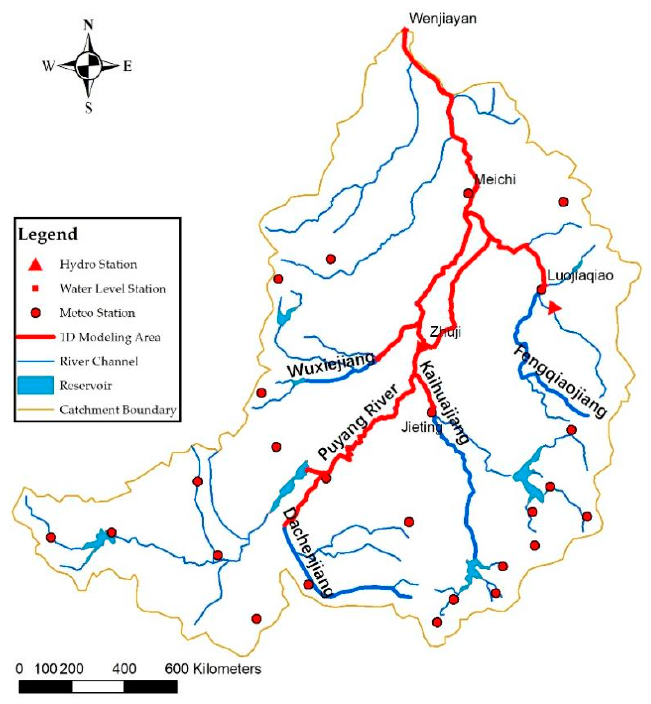
Figure 3. 1D hydrodynamic modeling area.